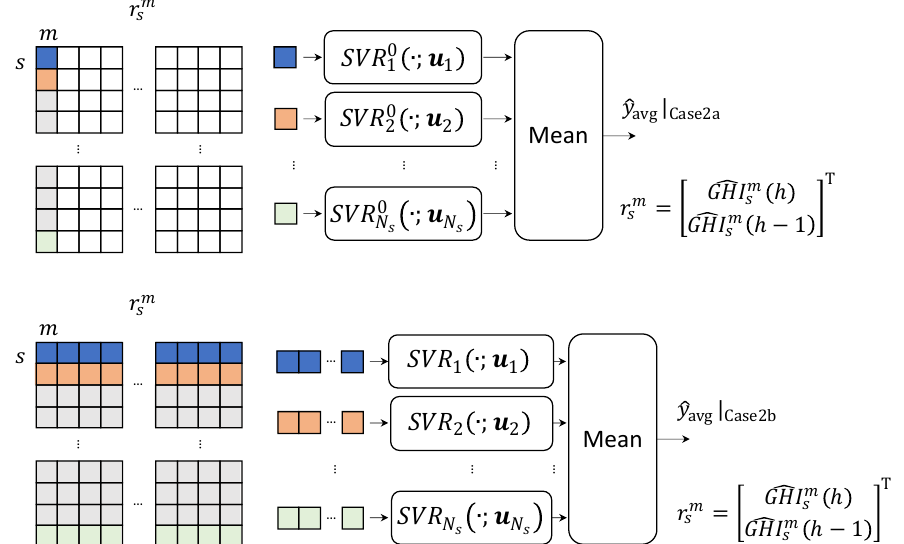
Figure 4. Schematic of the access of the MEPS’s GHI forecasts in Case2. Case2a-b predict local GHI at each site, and their predictions are averaged to obtain the regional GHI prediction. Case2a uses MSM’s GHI only, and Case2b accesses the all MEPS member’s GHI.